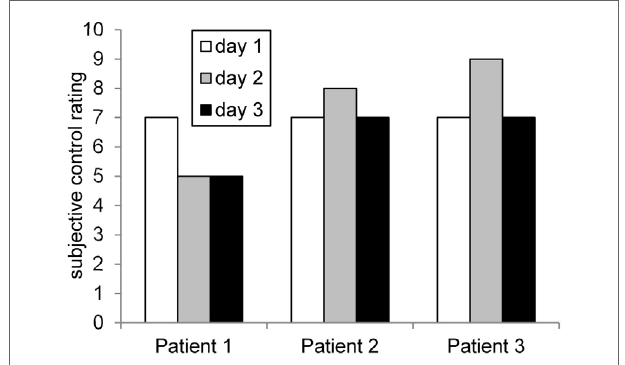
FIGURe 2 | Rating of subjective control over feedback signal across days . The profiles matched roughly the achieved ACC regulation (compare Figure 6